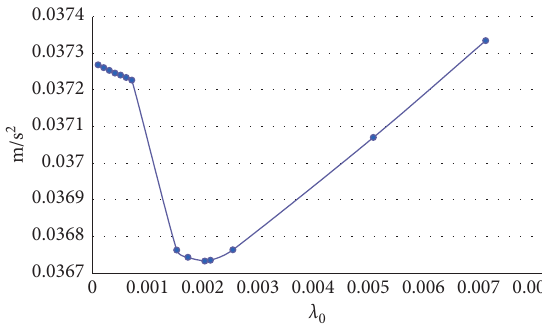
Figure 9: Graph for finding the Lasso optimal hyperparameters of the 8 th round.